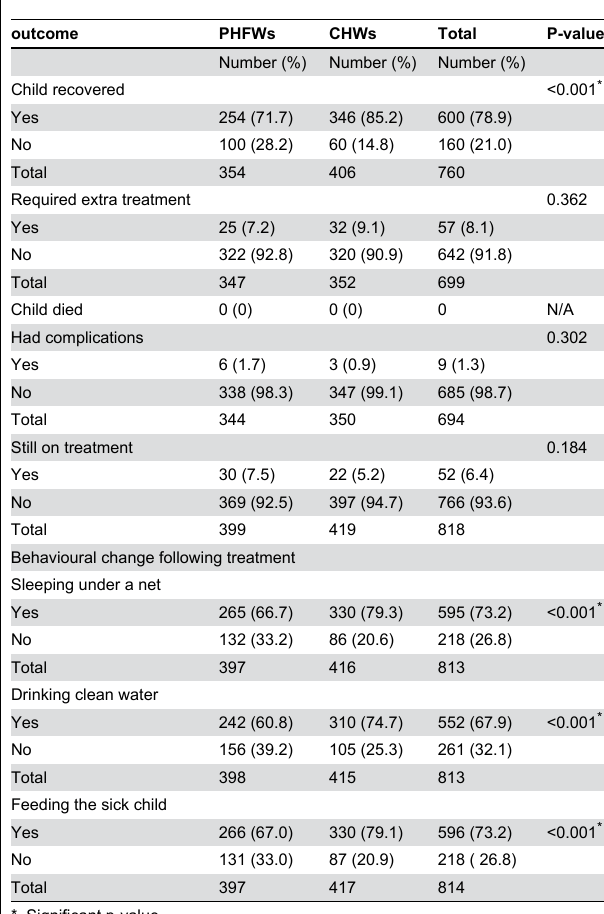
Table 5. Distribution of visit outcomes between CHWs and PHFWs.